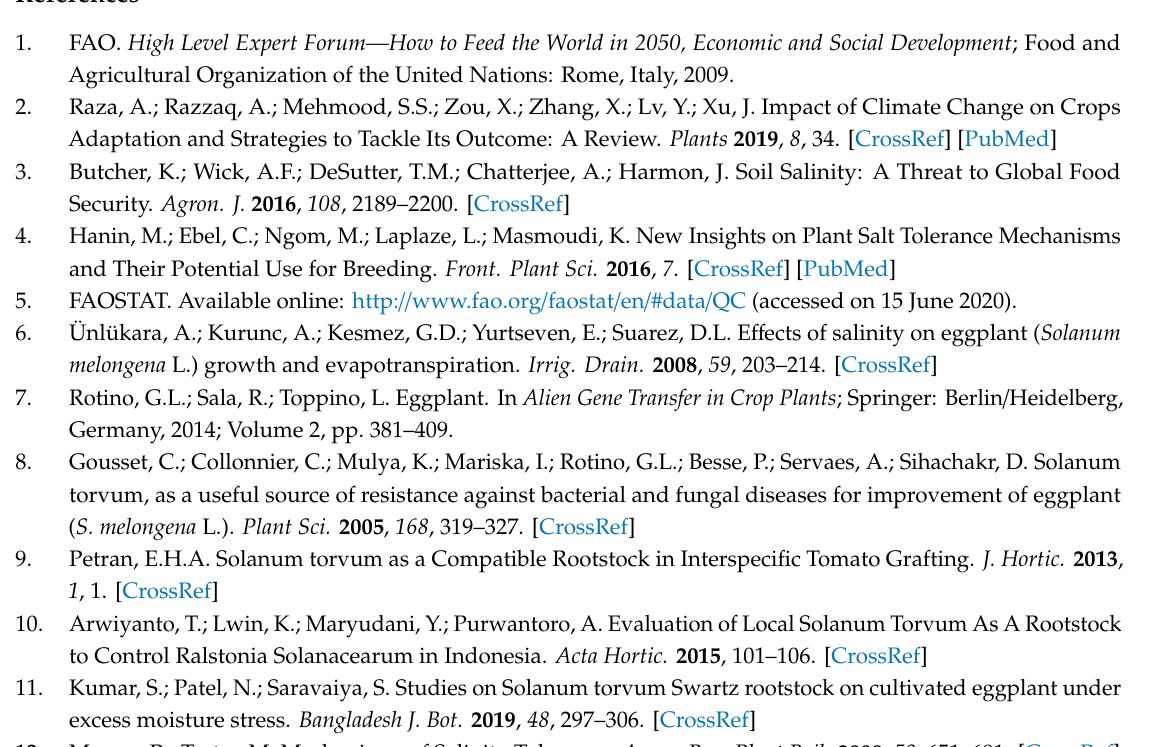
Table S1. Growth response measurements in S. melongena and S. torvum after 25 days of watering with the indicated NaCl concentrations. Numbers represent Mean ± SD ( n = 5). The same letters within each column indicate non-significant di ff erences between treatments for each species according to the Tukey test ( p < 0.05). Author Contributions: Conceptualization, O.V., J.P. (Jaime Prohens) and A.F.; methodology, M.B. (Marco